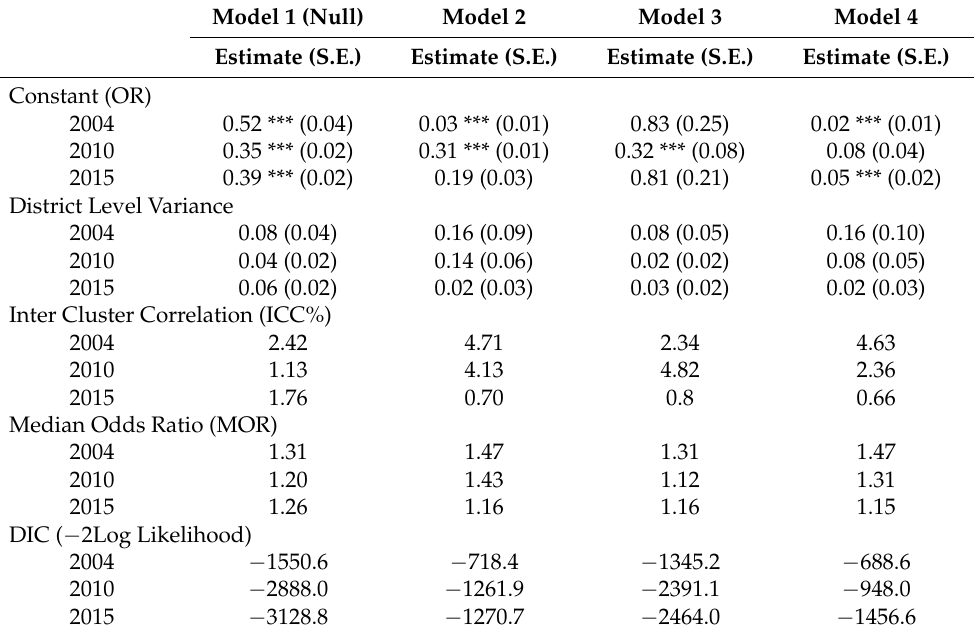
Table 5. Measures of